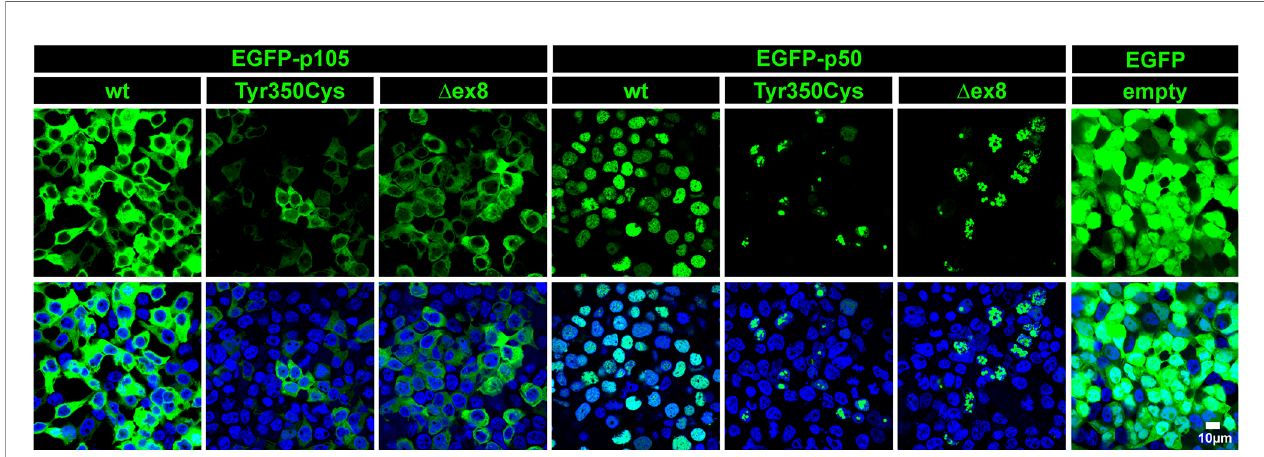
FIGURE 2 | The single amino acid change p.Tyr350Cys causes limited expression of p105 and subnuclear mislocalization of p50. In transiently transfected HEK293T cells, fl uorescence imaging of EGFP-tagged proteins (green) con fi rms normal cytoplasmic localization but limited expression of the p105-Tyr350Cys missense variant, similar to the p105 D ex8 internal deletion mutant (representing a pathogenic in-frame deletion of the cDNA sequences corresponding to exon 8 of NFKB1 ). The p50-Tyr350Cys shows an aberrant subnuclear localization pattern and accumulates in high-intense spot-like structures, indistinguishable from p50 D ex8, whereas wildtype p50 shows a uniform distribution within the nuclei (blue). Detector settings within the p105 and p50 panels were kept constant to demonstrate the differences in fl uorescence intensities. No speci fi c sub-cellular localization is obtained with the empty vector control. Identical results were observed at different time points (24-72 hours) using various DNA amounts. Representative examples (300 ng DNA each; 48 hours after transfection) are shown. Scale bar: 10µm. High-magni fi cation images are shown in Supplementary Figure 1